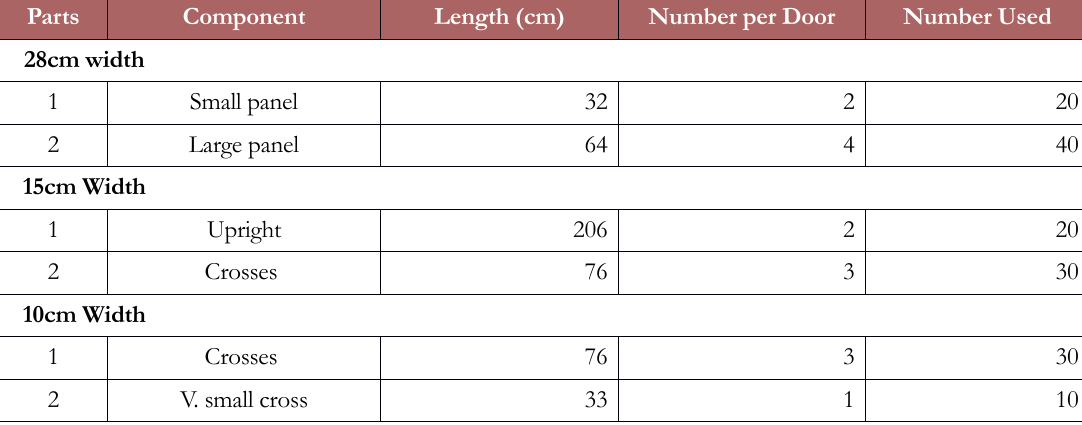
Table 5. Details parts list of the Panel